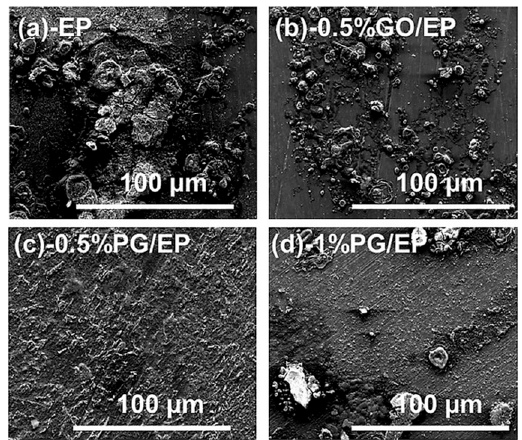
Figure 5. The morphology of the coatings after a corrosion test ( a ) Epoxy coating (EP); ( b ) 0.5% Graphene oxide / Epoxy coating (GO / EP); ( c ) 0.5% POSS-GO / Epoxy coating (PG / EP); ( d ) 1% POSS-GO / Epoxy coating (PG / EP). (Reprinted with permission from ref. [93] 2020 Elsevier).